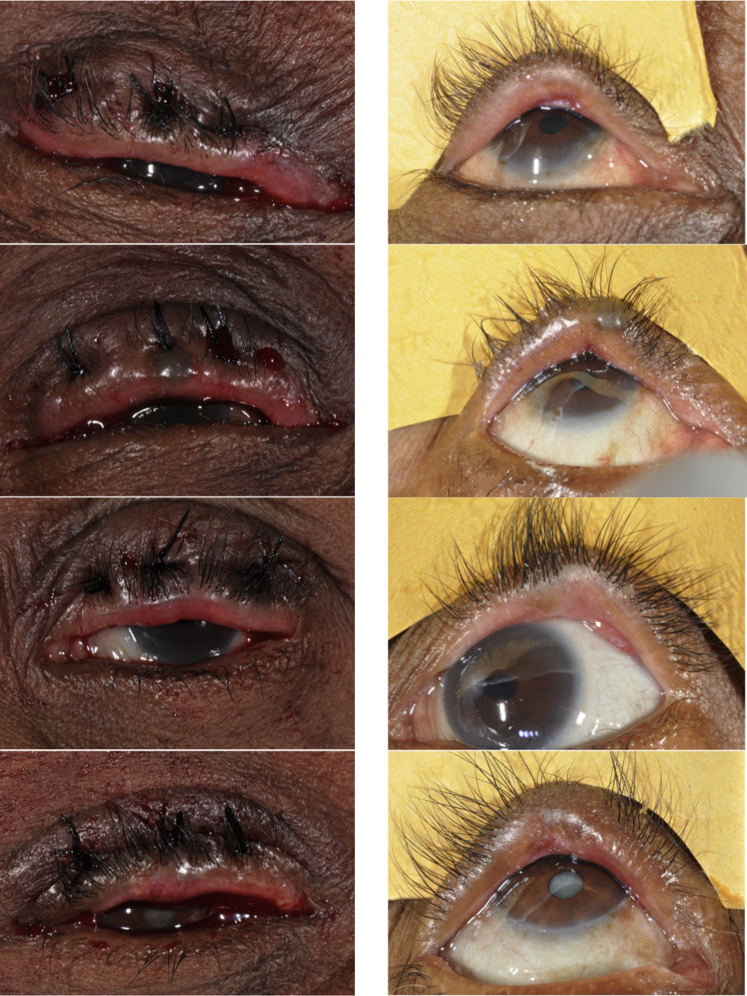
Suture distance asymmetry resulting in eyelid contour abnormality (ECA). Left: Immediate postoperative pictures showing asymmetry between suture intervals. Right: The 12-month follow-up pictures of the same eye with ECA.